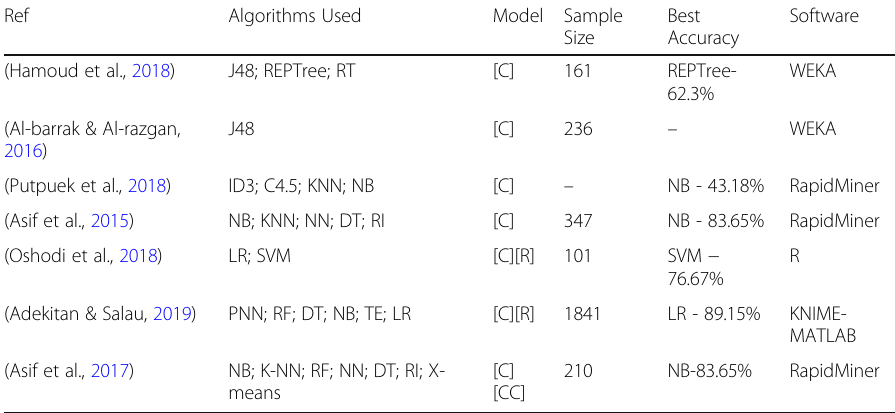
Table 2 Summary of results of research seeking degree level prediction